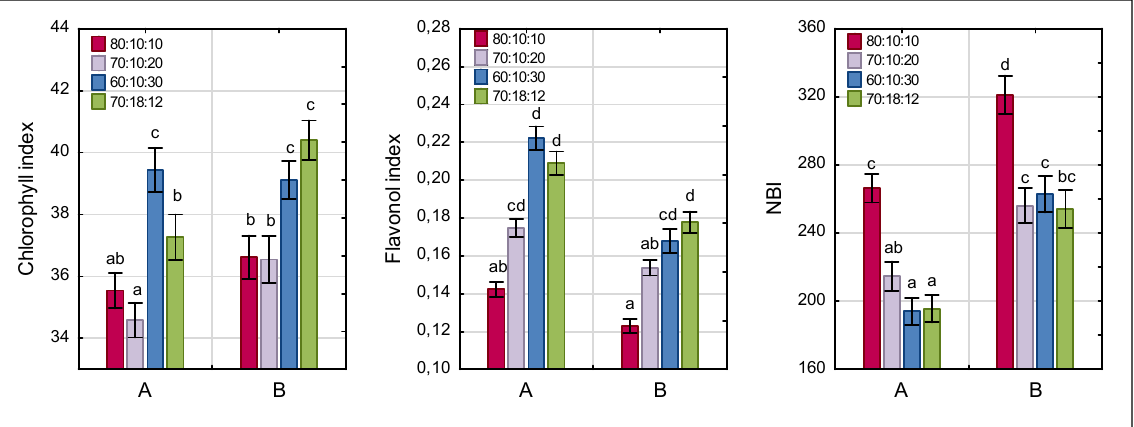
Figure 4. Chlorophyll index, flavonol index, and nitrogen balance index (NBI) of ‘Elizium’ romaine lettuce grown in a hydroponic system with different mineral concentrations of nutrient solution (A and B) under illumination with four different light spectra (R:G:B—80:10:10, 70:10:20, 60:10:30, and 70:18:12) in an indoor controlled environment. Bars represent the means ± SE. Means followed by the same letter are not significantly different ( p < 0.05) according to Tukey’s HSD test.